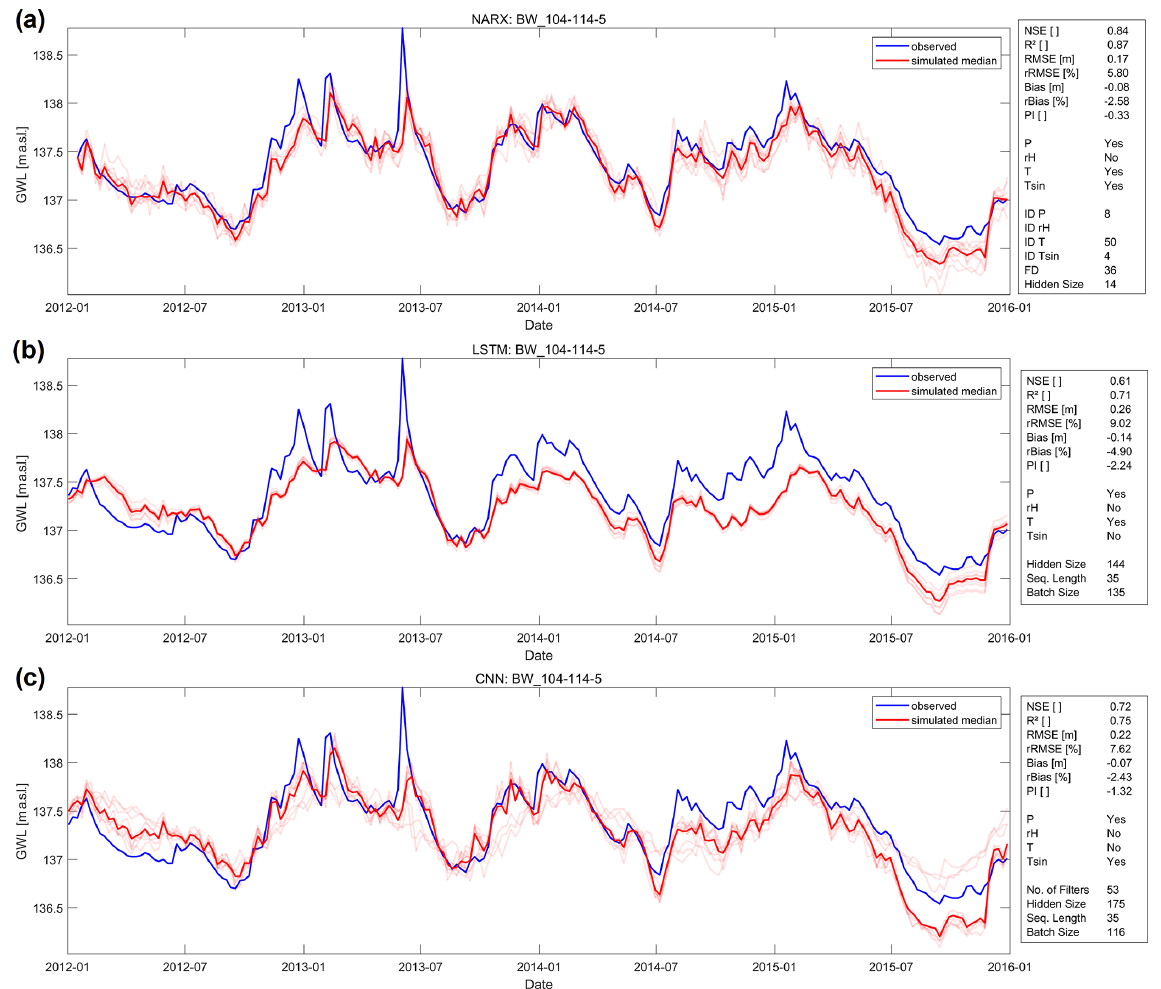
Figure 5. Forecasts of (a) a NARX, (b) a LSTM and (c) a CNN model for well BW_104-114-5 during the test period 2012–2016.